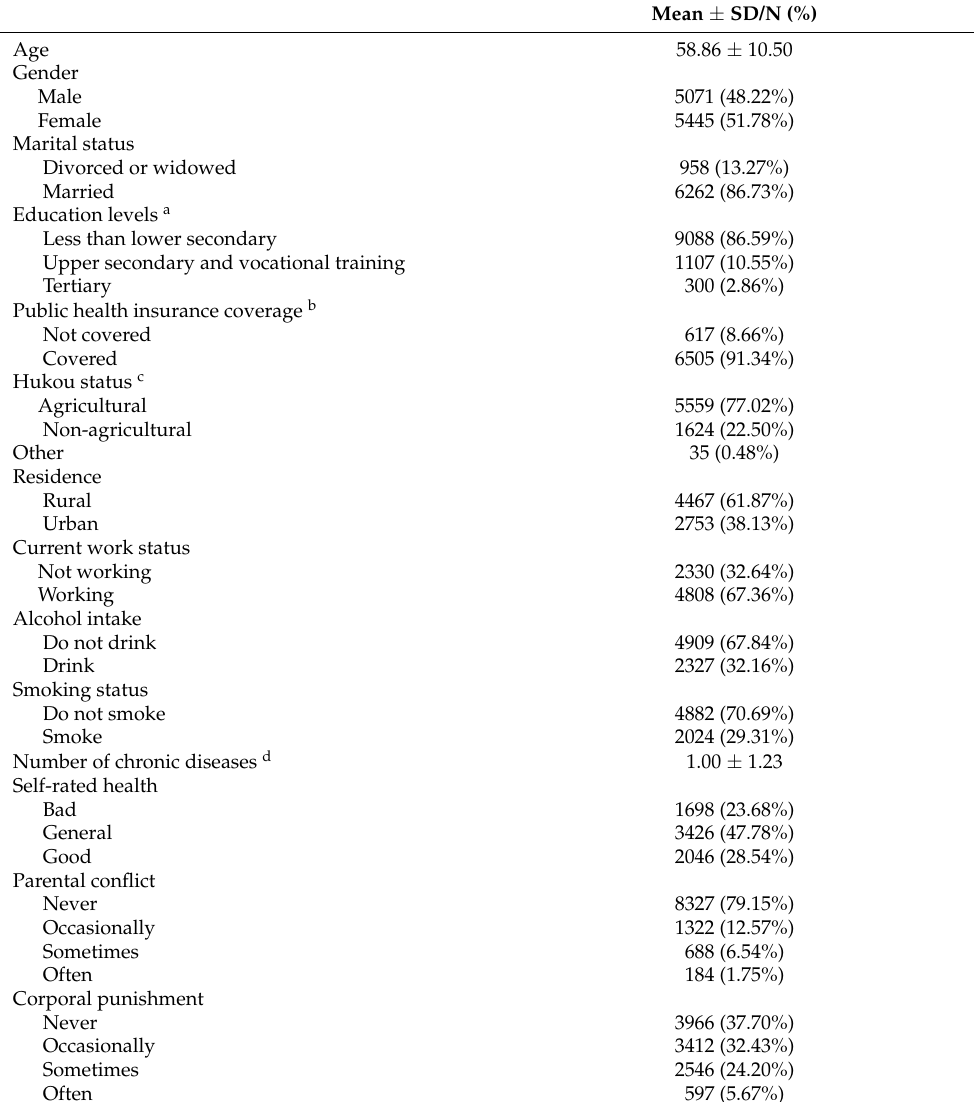
Table 1. Demographic characteristics and EDV status of the sample